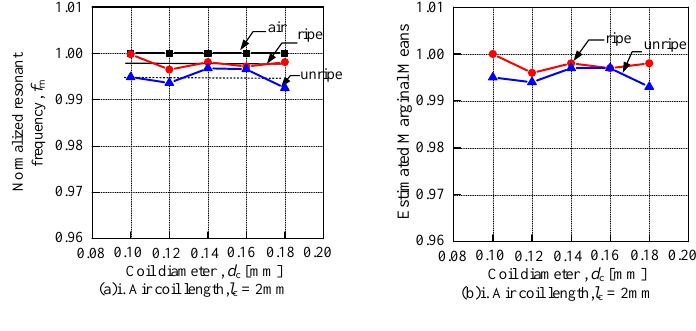
The deviation between ripe to unripe samples (  10 −3 ) Figure 9. Effects of air coil length. ( a ) The N f ( b ) The estimated marginal means versus coil